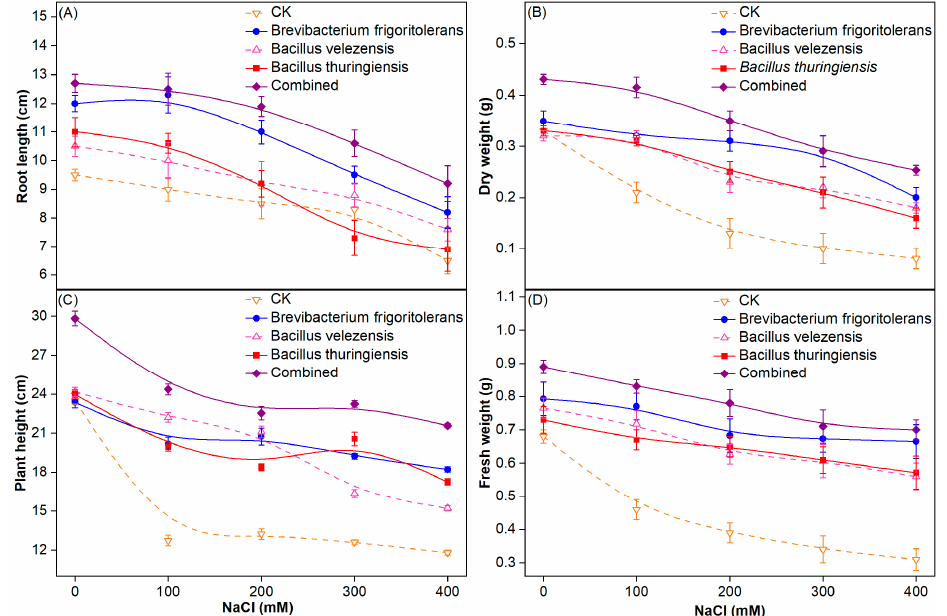
Figure 2. Effect of salt-tolerant plant growth promoting rhizobacteria (ST-PGPR) on wheat morpho- logical characteristics under NaCl stress: ( A ) wheat root length, ( B ) wheat dry weight, ( C ) wheat plant height, and ( D ) wheat fresh weight.